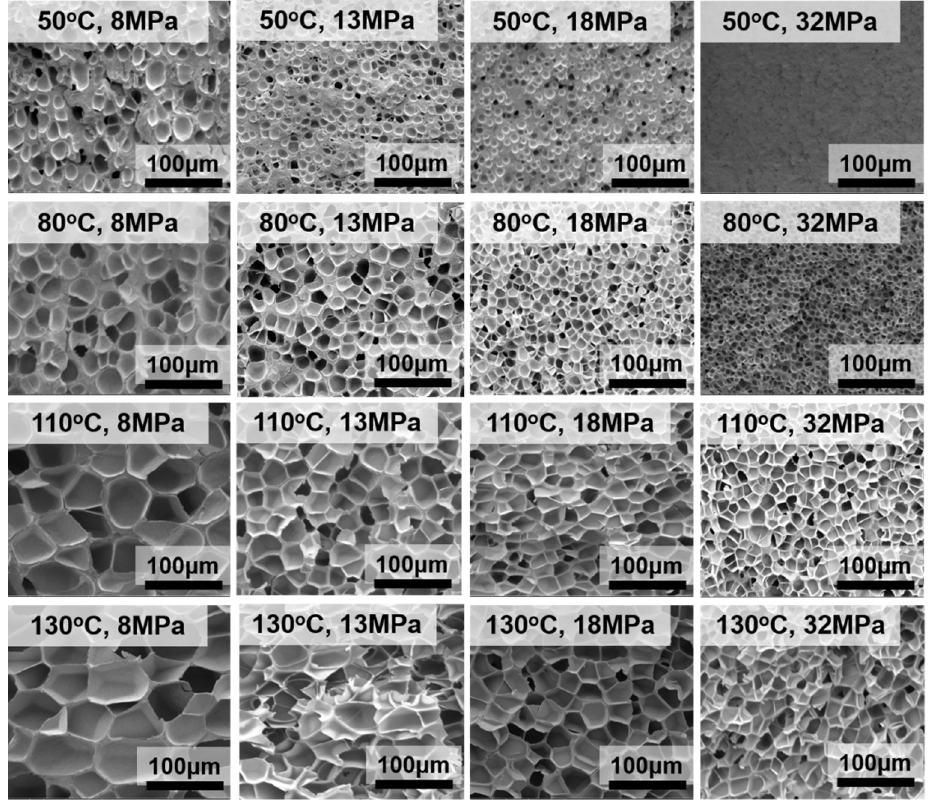
Figure 2. SEM images of typical foamed samples synthesized under various foaming conditions.